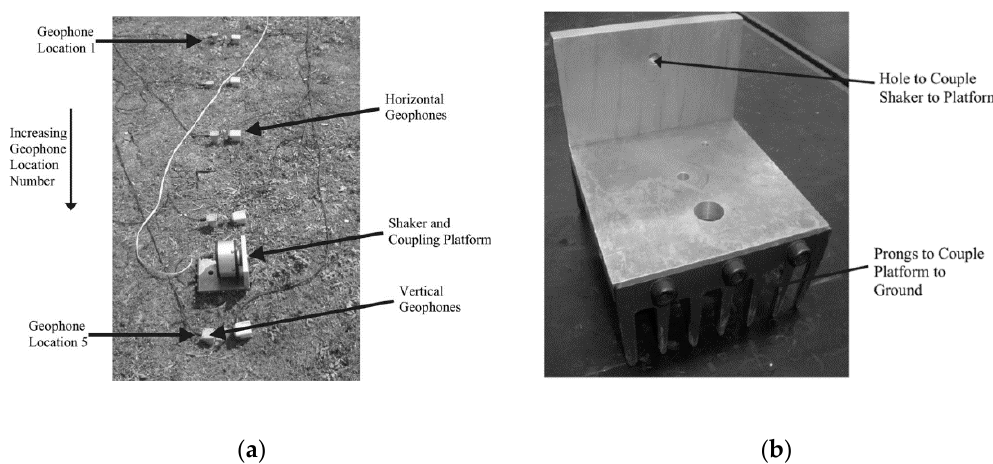
Figure 12. ( a ) Experimental set-up for compressional wave method; ( b ) specially designed platform used to couple the shaker to ground [101], Copyright AIP Publishing, 2011.